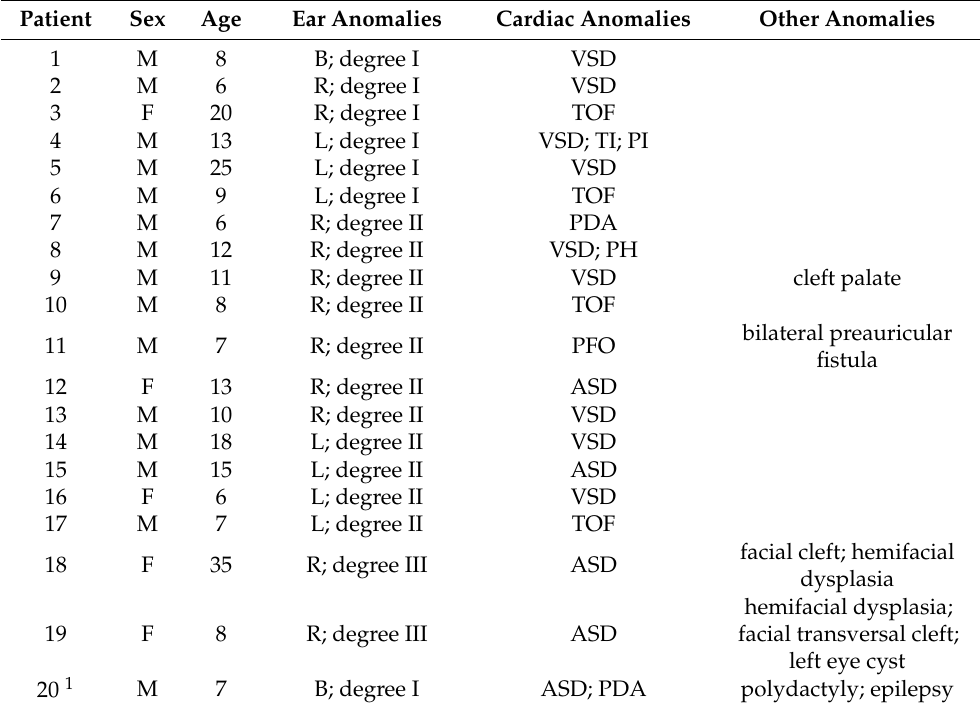
Table 1. Summary of the clinical features observed in 20 patients included in our